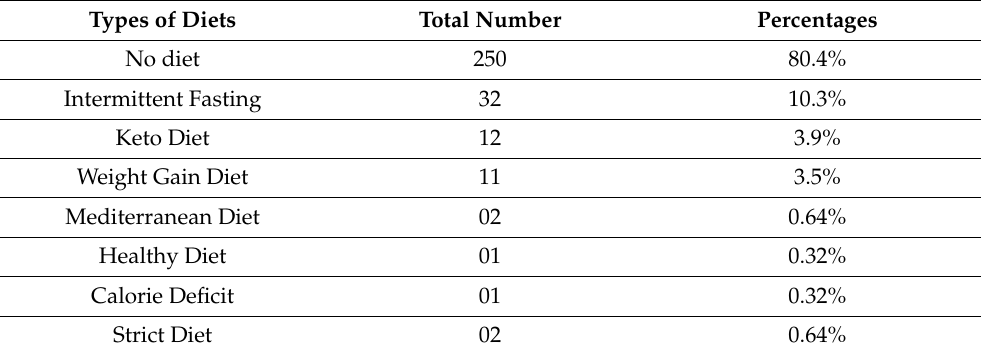
Table 3. Students who followed different patterns of dietary